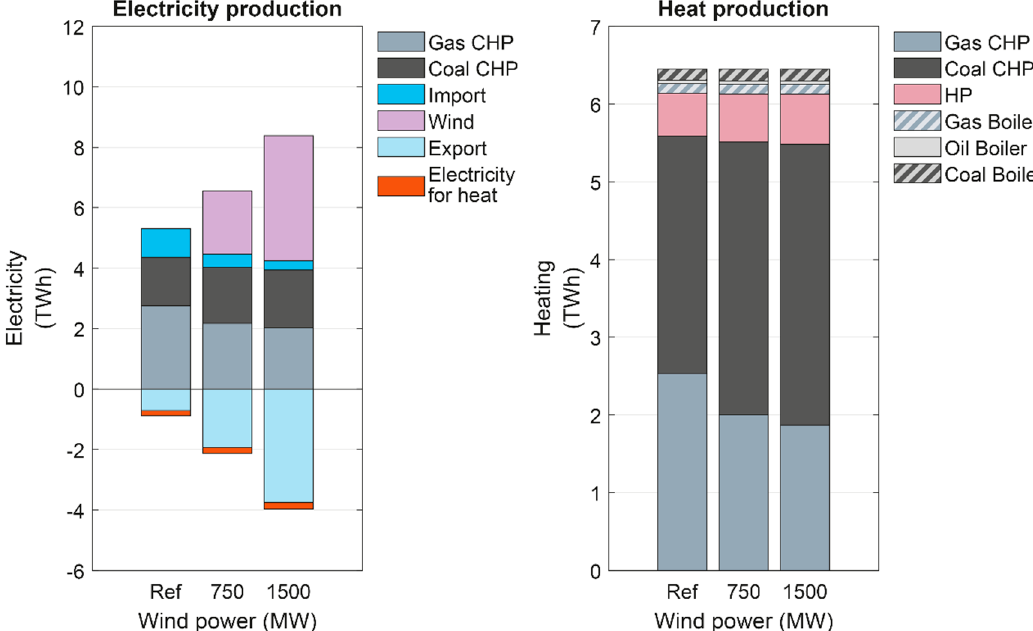
Figure 4. Changes in the power and heat production shares when wind power is integrated into the present energy system of Helsinki (Reference system, 2016).